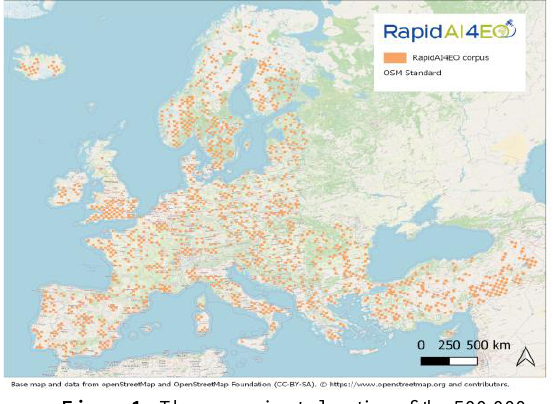
Figure 1. The approximate location of the 500,000 RapidAI4EO patches